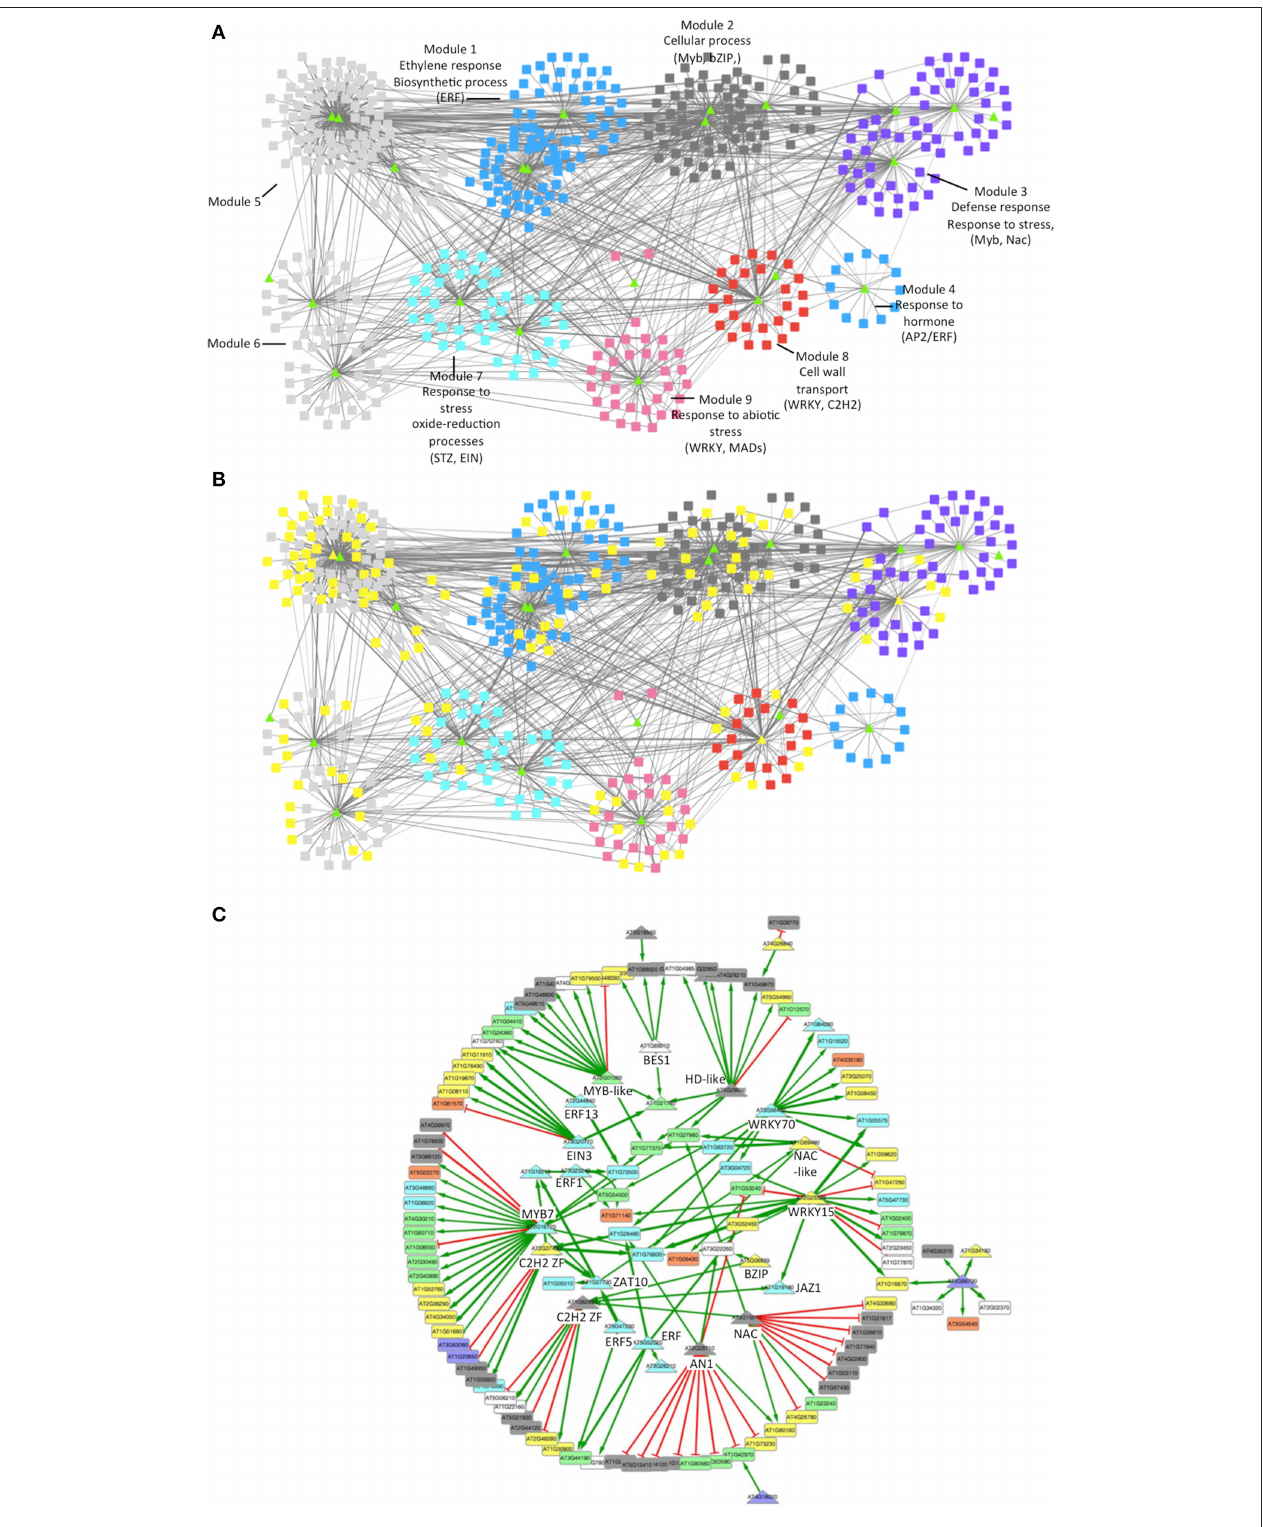
FIGURE 5 | Network analysis of transcriptomics data predicts a B. cinerea -responsive regulatory gene network affected by the plant N-status. (A) Network analysis of genes with significant N/B ANOVA model. Genes are presented as triangles (TFs) and rectangles (target genes). Colors are used to